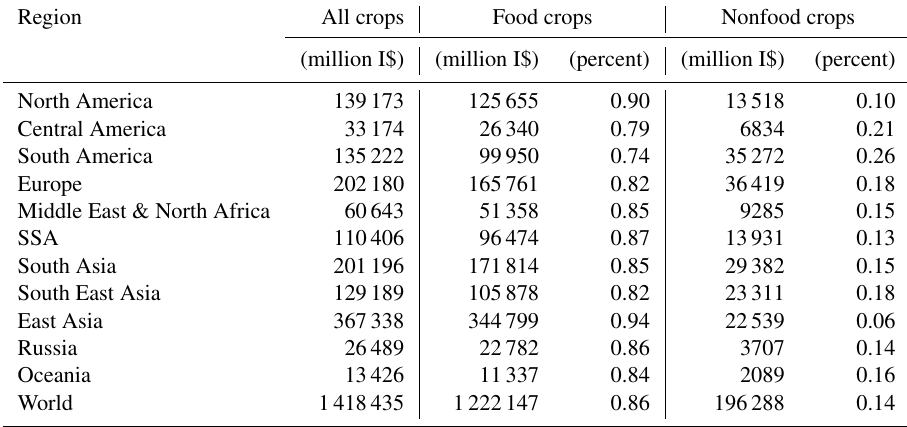
Table 4. Value of production for all crops as well as food and nonfood crops in various regions. Region All crops Food